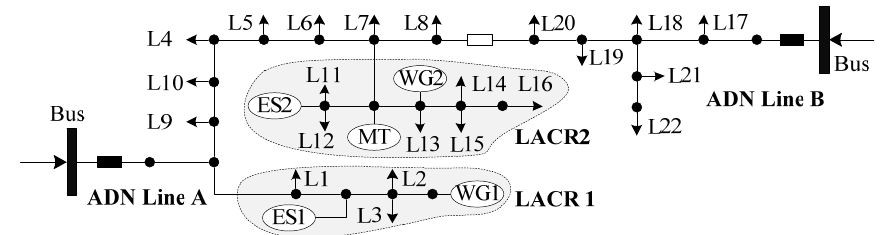
Figure 6. Topological connection of ADN.